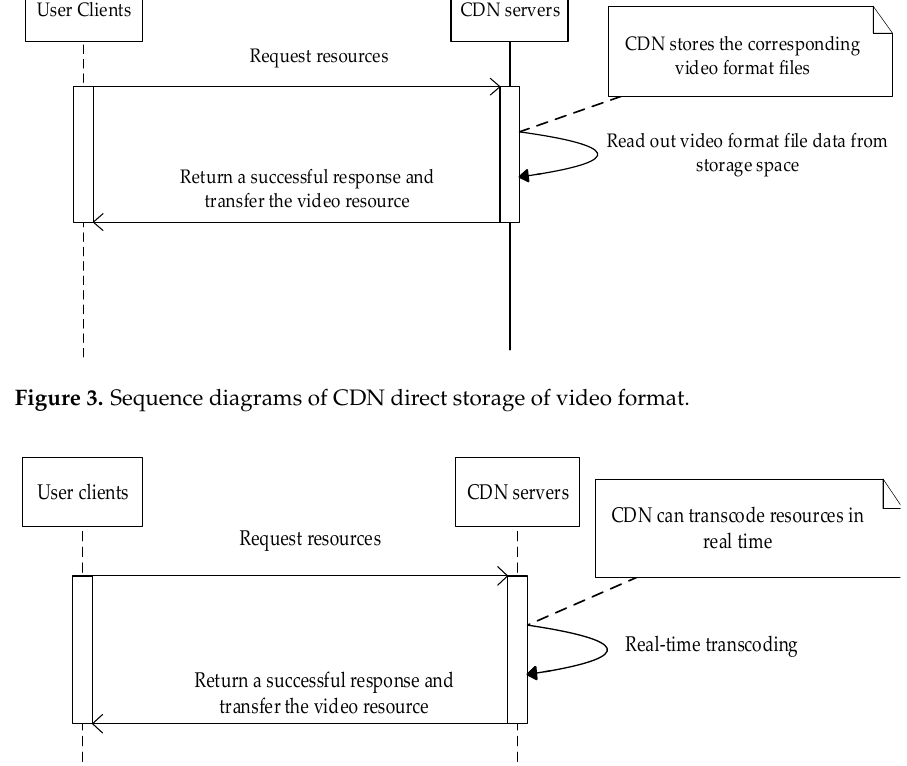
Figure 4. Sequence diagram of CDN feasible transcoding.